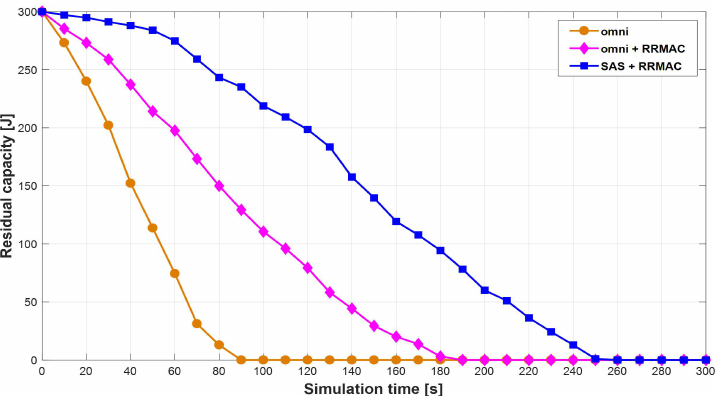
Figure 4. Residual capacity